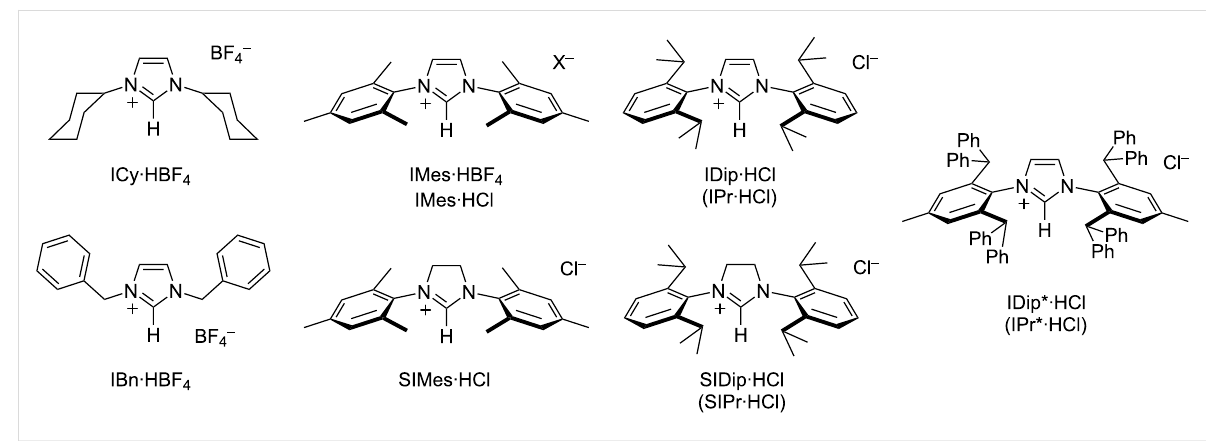
Figure 1: Structures of the imidazolium and imidazolinium salts discussed in this study and their acronyms.